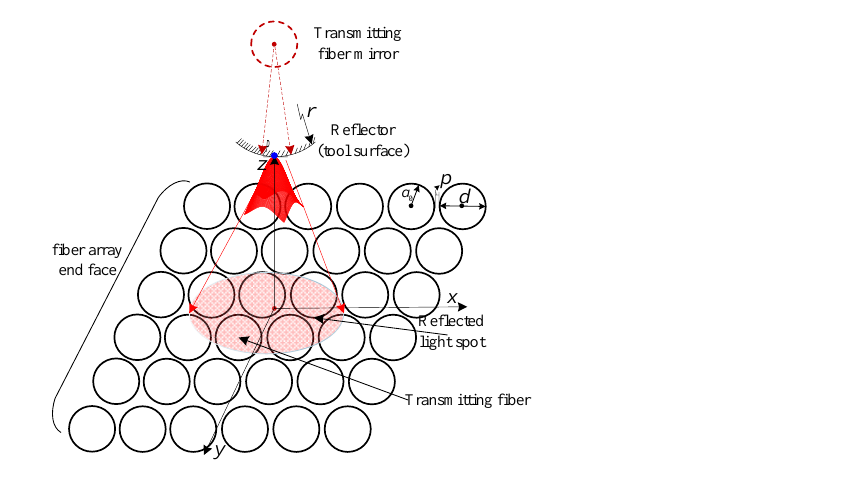
Figure 2. The relative position of tool reflection surface and fiber matrix probe face. Mark the space coordinates of a reflection point 𝑝 on the tool as (𝑋 𝑖 , 𝑌 𝑗 , 𝑍 𝑘 ) , where X i ∈ [ 0, 5 ( d + p )] , Y j ∈ [ 0, 5 ( d + p )] , Z k ∈ [ z 1 , z 2 ] . Its spatial position can be encoded by both the position matrix and intensity matrix. The position matrix is denoted as M ab , as shown in Figure 3a and Equation (1).